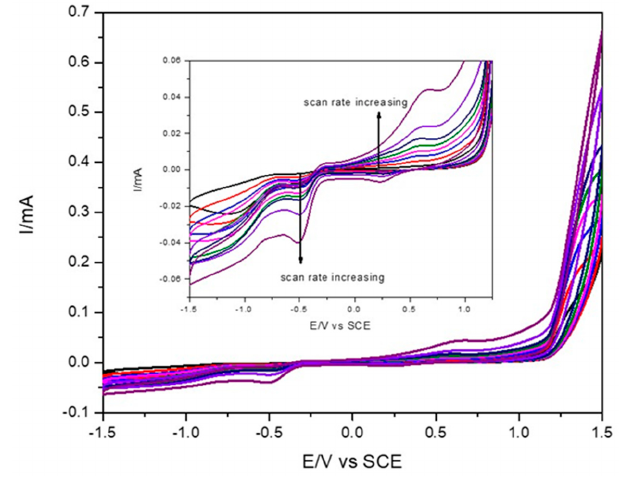
Figure 6. CVs recorded at Zn_tpy/GC electrode in 0.1 M NaOH supporting electrolyte at various scan rates of: 0.01; 0.02; 0.03; 0.05; 0.06; 0.1; 0.2 V · s − 1 (curves 1–8) within potential range from − 1.5 V to +1.5 V vs. SCE.